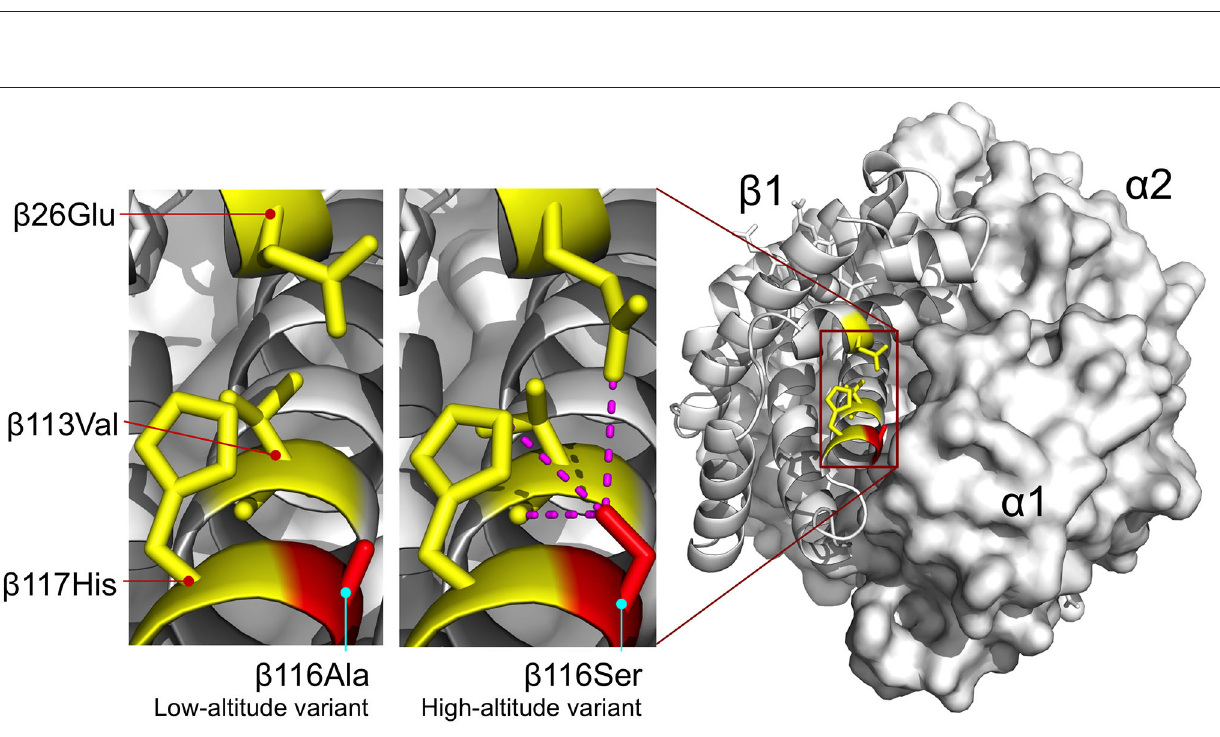
FIGURE 7 | Homology model of yellow-billed pintail HbA showing the location of an affinity-enhancing β 116Ala → Ser replacement that distinguishes high- and low-altitude variants. Replacement of the nonpolar Ala for an uncharged, polar Ser at the α 1 β 1 intradimer contact surface is predicted to increase Hb-O 2 affinity by stabilizing the R-state via intra-subunit hydrogen bonds between the γ -oxygen of β 116Ser and each of three β -chain residues: β 26Glu ( ε 2-oxygen), β 113Val (carbonyl oxygen), and β 117His ( ε 2-nitrogen). Homology modeling indicates that the same network of interhelical bonds is not present in the T-state. Reproduced from Natarajan et al.